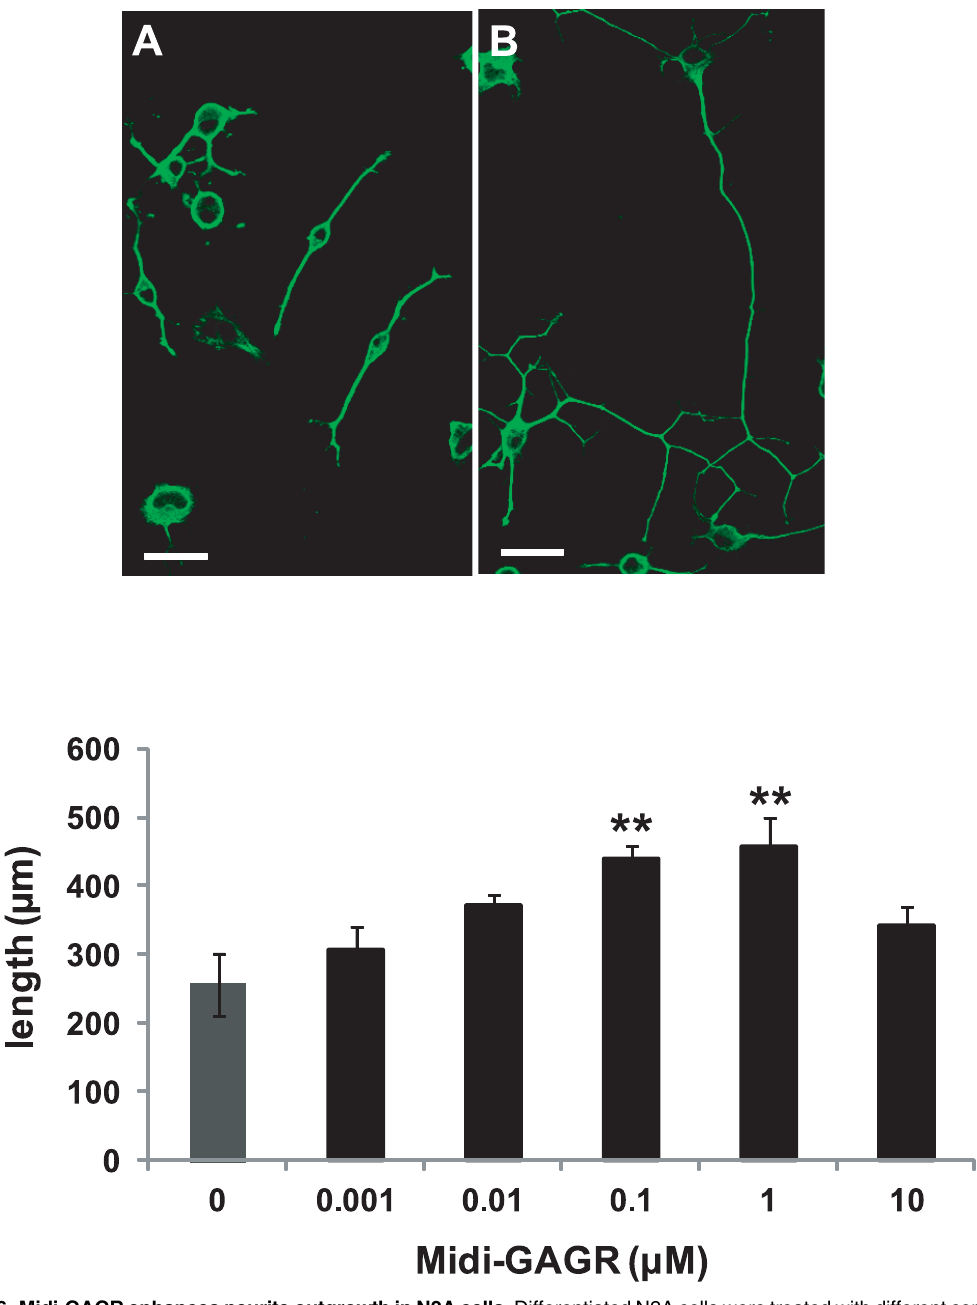
Fig 6. Midi-GAGR enhances neurite outgrowth in N2A cells. Differentiated N2A cells were treated with different concentrations of midi-GAGR for 48 h and immunostained using anti- α -tubulin antibody. Representative confocal images of N2A cells treated with either H 2 O (vehicle) (A) or 1 μ M midi-GAGR (B). Scale bar = 30 μ m. (C) Bar graphs show the average total neurite lengths of N2A cells treated with different concentrations of midi-GAGR (mean ± SEM of, at least, three independent experiments). * , p < 0.05 compared to control.